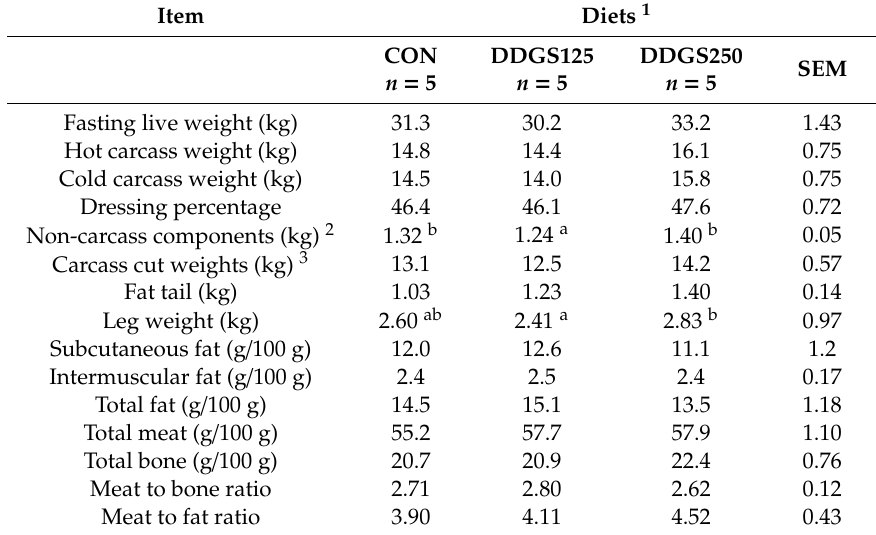
Table 4. E ff ects of feeding dried distillers’ grains with solubles (DDGS) on carcass, non-carcass components, dissected leg carcass cut weights and percentages of growing Awassi lambs.